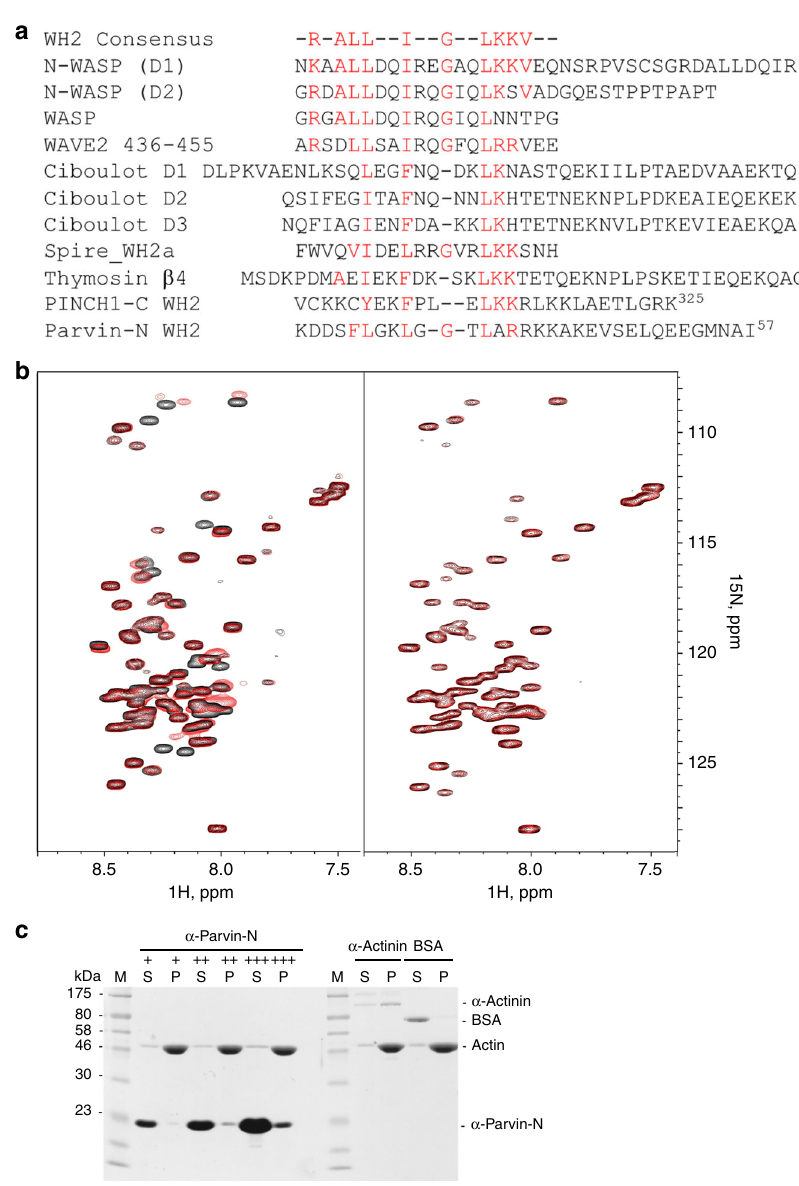
Fig. 3 Identi fi cation of actin-binding WH2 motifs in PINCH-1 and α -Parvin. a Sequence alignment of PINCH-1 C-terminal tail and α --terminus with representative WH2 motifs found in other proteins showing the presence of distinct WH2 motifs in PINCH and Parvin. b 0.1 mM 1 H- 15 N HSQC of α -Parvin- N in the absence and presence of 0.2 mM AP-actin showing that α -Parvin-N has potent binding to G-actin (left panel). Mutation of putative G-actin- binding residues L37A/R39A/R40A/K41A/K42A ( α -Parvin 5 A) drastically reduces actin binding (right panel). c Co-sedimentation assay showing α - Parvin-N binds to F-actin potently. + , ++ , +++ correspond to the concentration of α -Parvin-N at 7.7 μ M, 23.0 μ M, and 76.7 μ M,